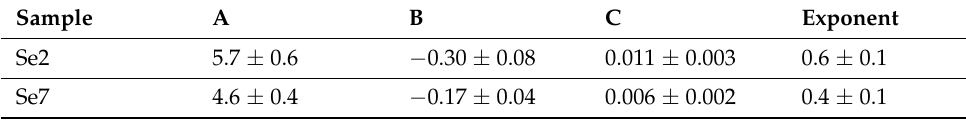
Table 4. The EMA analysis composition of model 3.